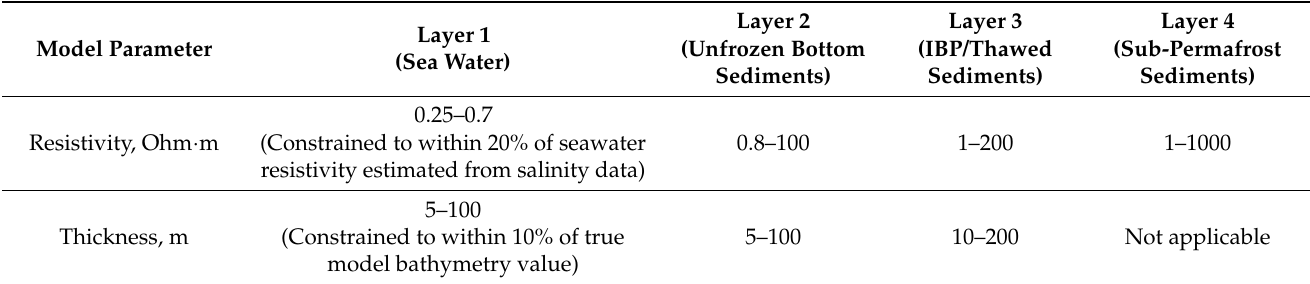
Table 7. Bounds for model parameters used in 4-layer constrained